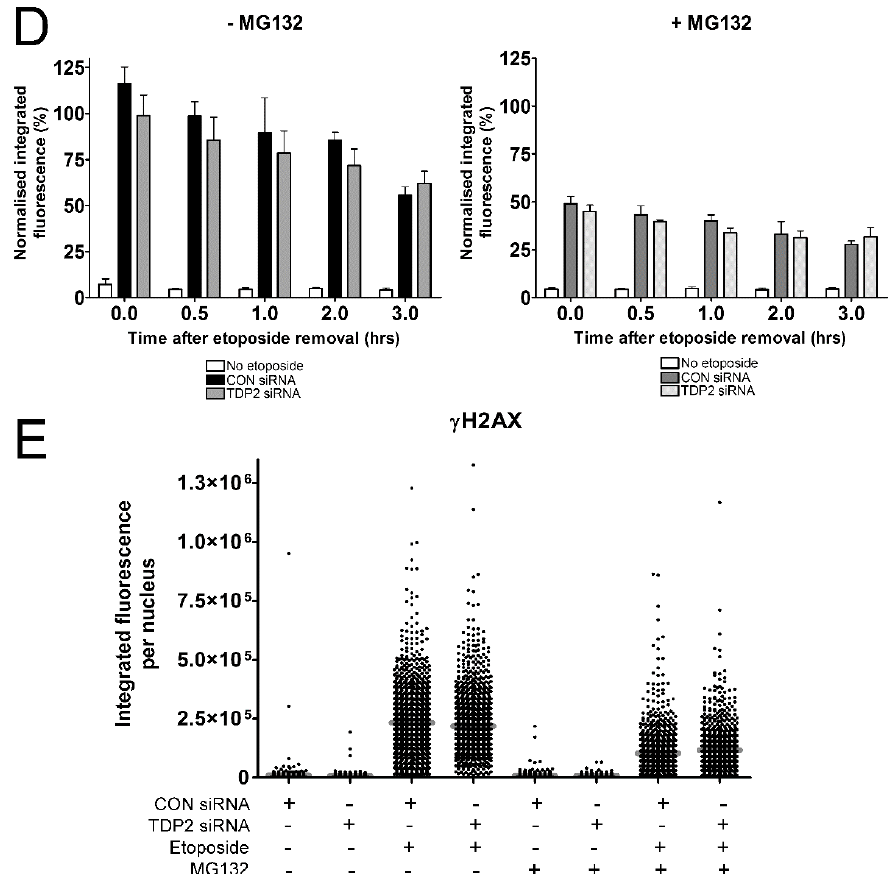
Figure 4. Effect of TDP2 siRNA knockdown on levels of etoposide-induced TOP2-DNA complexes and histone H2AX phosphorylation following proteasomal inhibition. ( A ) Expression of the ZATT SUMO ligase (ZNF451) in K562 cells, shown by western blot. ( B ) siRNA-mediated knockdown of TDP2 in K562 cells from four biological replicates from experiments shown in Figure 4B,C. Cells were transfected with 500 nM TDP2 siRNA #1 or non-coding (CON) siRNA and used for TARDIS and G H2AX assay 72 h after electroporation. ( C ) Control or TDP2 siRNA knockdown cells were treated with 100 µ M etoposide and 10 µ M MG132 for 2 h, followed by incubation in etoposide-free medium containing MG132 for 0, 0.5, 1 or 2 h. Levels of TOP2A- and TOP2B- DNA complexes were measured using the TARDIS assay. Values are normalised to a 2 h 100 µ M etoposide control and compared by two-way ANOVA ( n = 4). ( D ) Control or TDP2 siRNA knockdown cells were treated with 100 µ M etoposide alone or in combination with 10 µ M MG132 for 2 h, followed by incubation in etoposide-free medium containing solvent or MG132 for 0, 0.5, 1, 2, or 3 h. Level of etoposide-induced histone H2AX phosphorylation was measured using the G H2AX assay. Values are normalised to a 2 h 100 µ M etoposide control and compared by two-way ANOVA ( n = 3). ( E ) Data from Figure 4D is presented as a scatter plot of raw integrated fluorescence values of G H2AX signal in individual cells ( n = 1). Data is shown for CON siRNA and TDP2 siRNA knockdown cells treated continuously with 100 µ M etoposide (or DMSO) for 2 h, alone or in combination with 10 µ M MG132 as